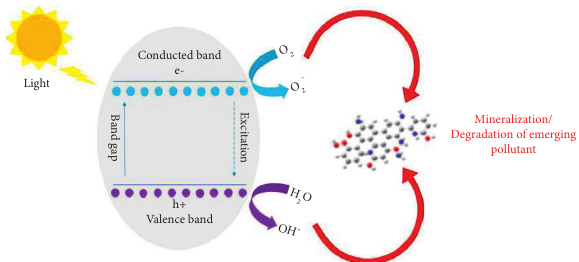
Figure 5: Mechanism of photocatalytic degradation of